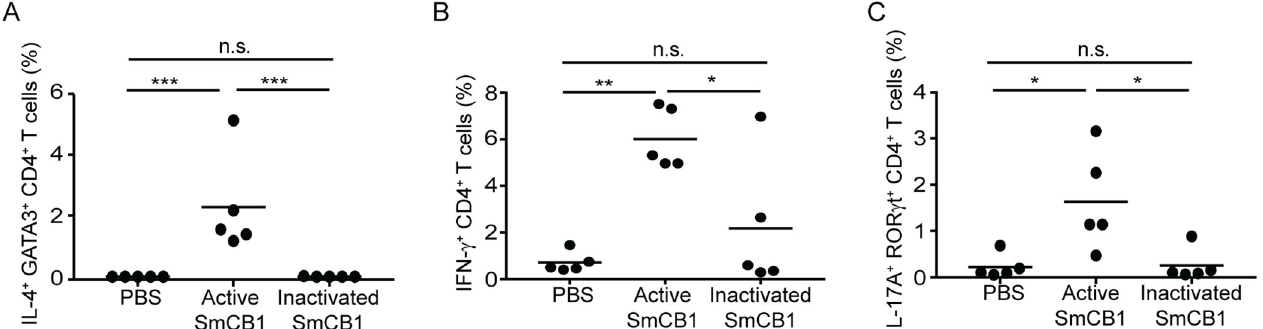
Fig 4. The capacity of SmCB1 to induce T H 2, T H 1 and T H 17 cells is dependent on its proteolytic activity. On day 22, intracellular cytokine/transcription factor staining and flow cytometry were used to determine the frequencies of IL4 + GATA3 + CD4 + T cells (A), IFN- γ + CD4 + T cells (B), and IL-17A + ROR γ t + CD4 + T cells (C), in the mesenteric lymph nodes of wild type C57BL/6 mice that received injections of PBS, active SmCB1, or inactivated SmCB1, on days 0, 14 and 21 by the intraperitoneal route. n.s., P > 0.05; � , P < 0.05; �� , P < 0.01; ��� , P <